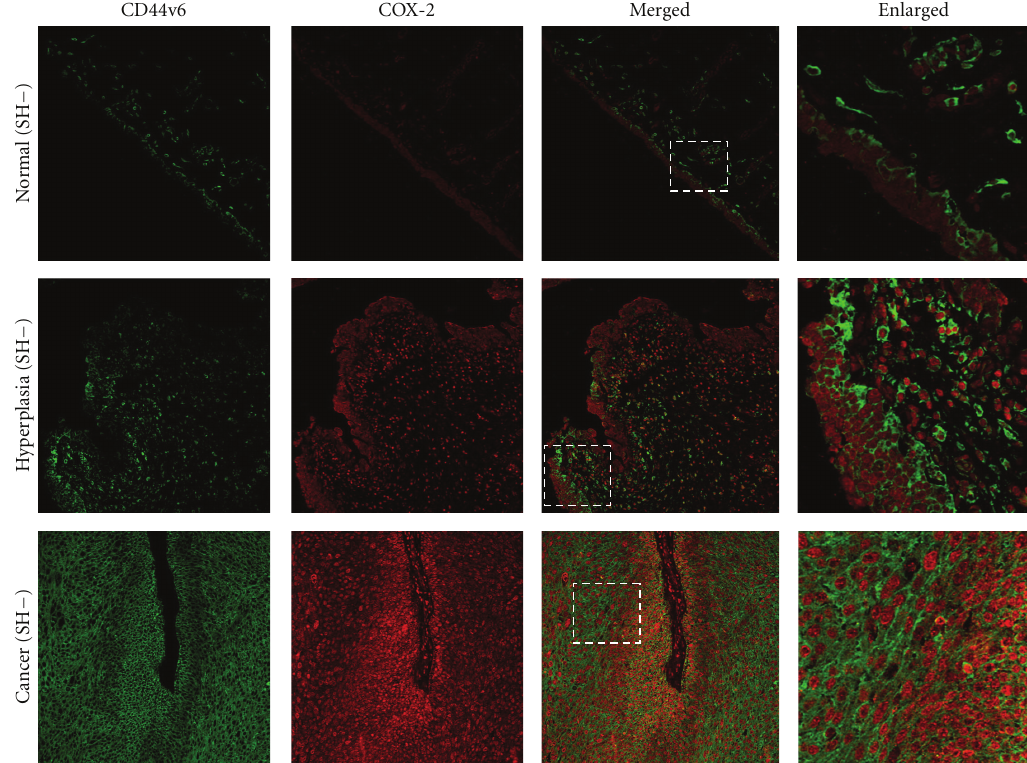
Figure 3: Localization of CD44v6 and COX-2 in urinary bladder samples. The distribution of CD44v6 (green) and COX-2 (red) was determined by double immunofluorescence in normal tissue, hyperplasic tissue nearby tumor, and cancer of urinary bladder tissue. These subjects had other risk factors without S. haematobium infections. Original magnification is 200x. Enlarged: enlargement of dotted areas. SH: S. haematobium